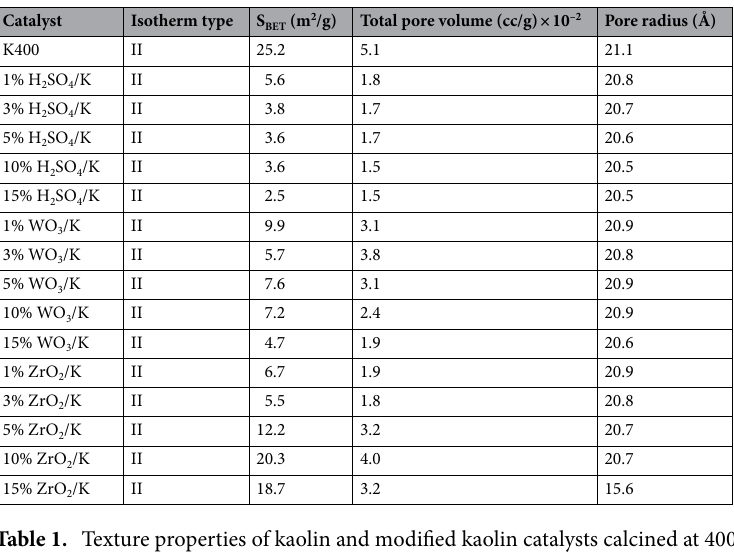
Table 1. Texture properties of kaolin and modified kaolin catalysts calcined at 400 °C.